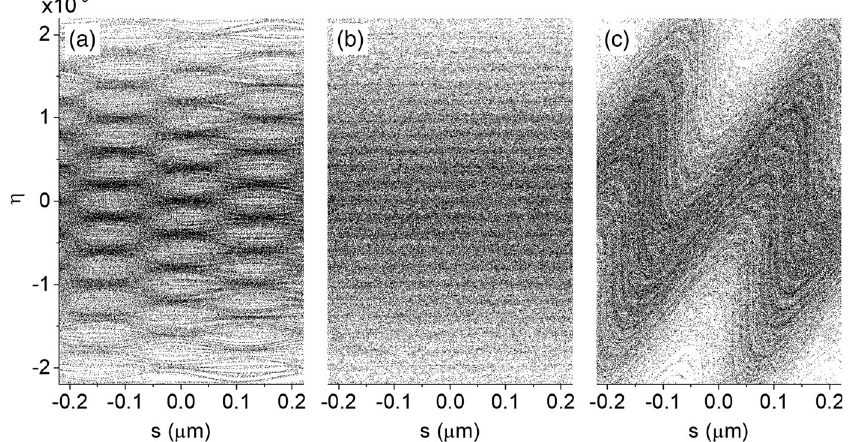
FIG. 5. Simulation results in terms of the macroparticle distributions: (a) after the first modulator as indicated by (3) in Fig. 1, (b) before the second modulator (4), and (c) before the radiator